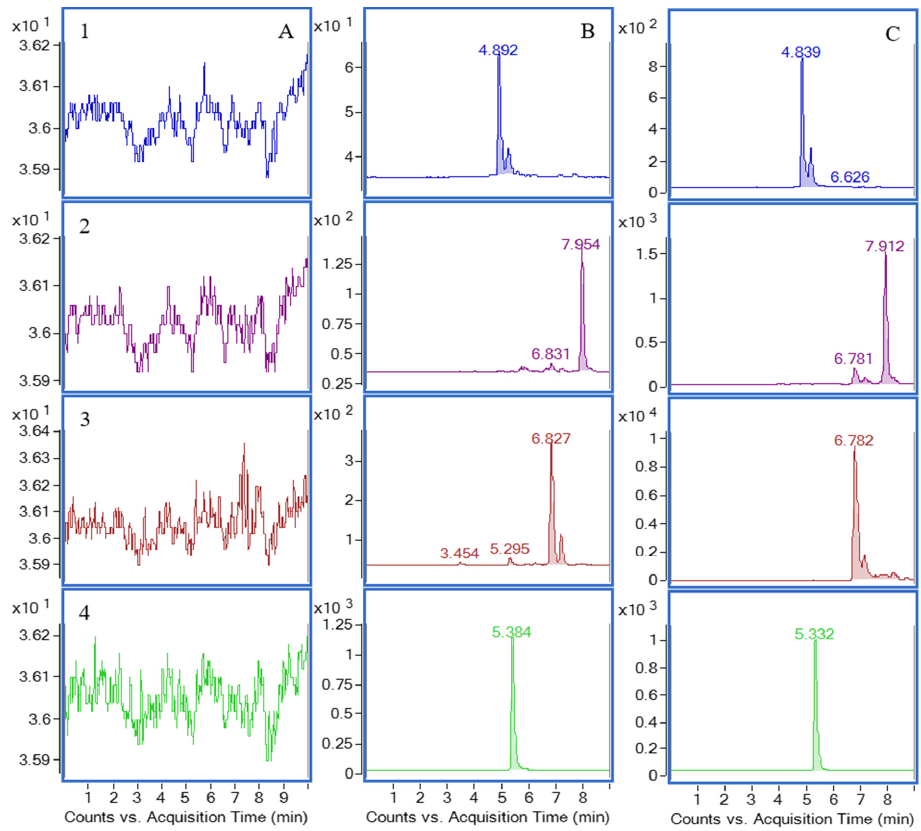
Figure 2. Chromatograms of the three components and I.S. in rat plasma: ( A ) blank plasma; ( B ) blank plasma spiked with the three analytes (MQC) and I.S.; ( C ) plasma sample obtained at 0.5 h from a rat after oral administration of rosemary extract, channel 1 for rosmanol (568.3 ng/mL); channel 2 for carnosic acid (27,948 ng/mL); channel 3 for carnosol (1825.1 ng/mL); channel 4 for I.S. The precursor ion of rosmanol was at m/z 345.1 Da ([M − H] − ), and the product ion peak at m/z 283.0 was attributable to one molecule of CO 2 and one molecule of H 2 O loss (62 Da). The precursor ion of butylparaben (C 11 H 14 O 3 ) was at m/z 193.0 Da ([M − H] − ), and the product ion peak at m/z 92.0 was attributable to a COO(CH 2 ) 3 CH 3 loss (101 Da). Table 1 shows the MS/MS transitions and energy parameters of all the compounds. Table 1. MRM transition in negative ion mode, and collision energy, quantifier and qualifier ions for the determination of the analytes and I.S.